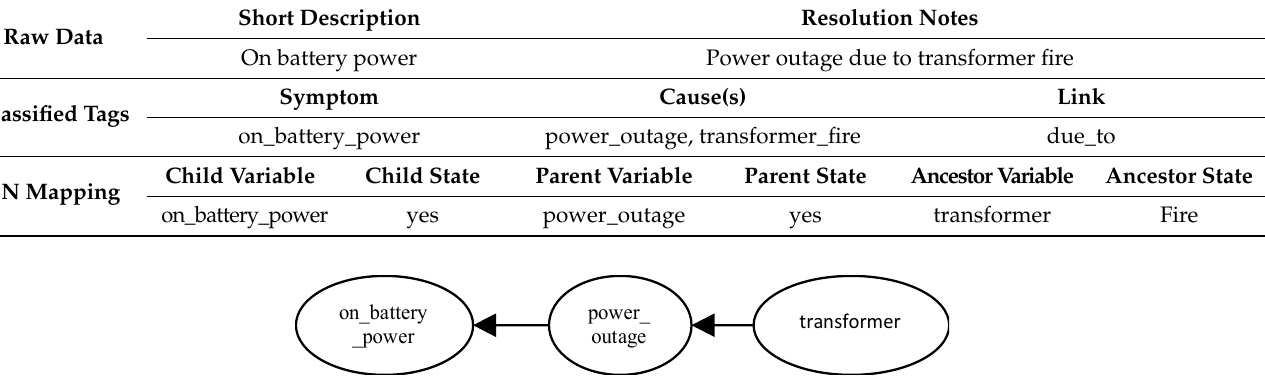
Figure 5. Corresponding Bayesian network graph for example in Table 3.